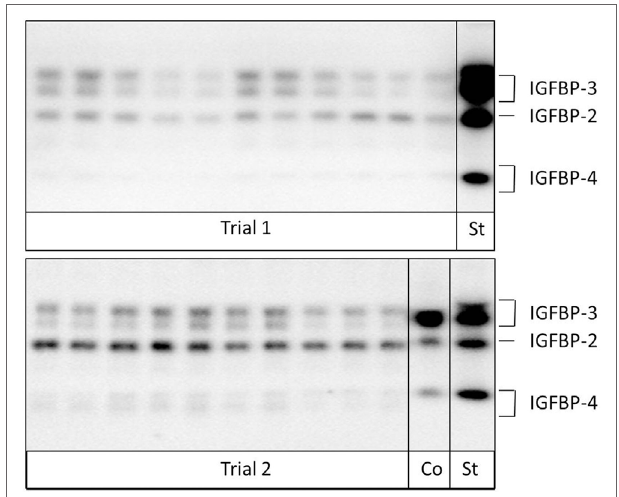
FigUre 1 | Analysis of insulin-like growth factor-binding proteins (IGFBPs) in samples from pregnant and non-pregnant cows by Western ligand blotting. Due to protein glycosylation, IGFBP-3 and -4 can be detected as band doublets (Co: internal control; St: human recombinant